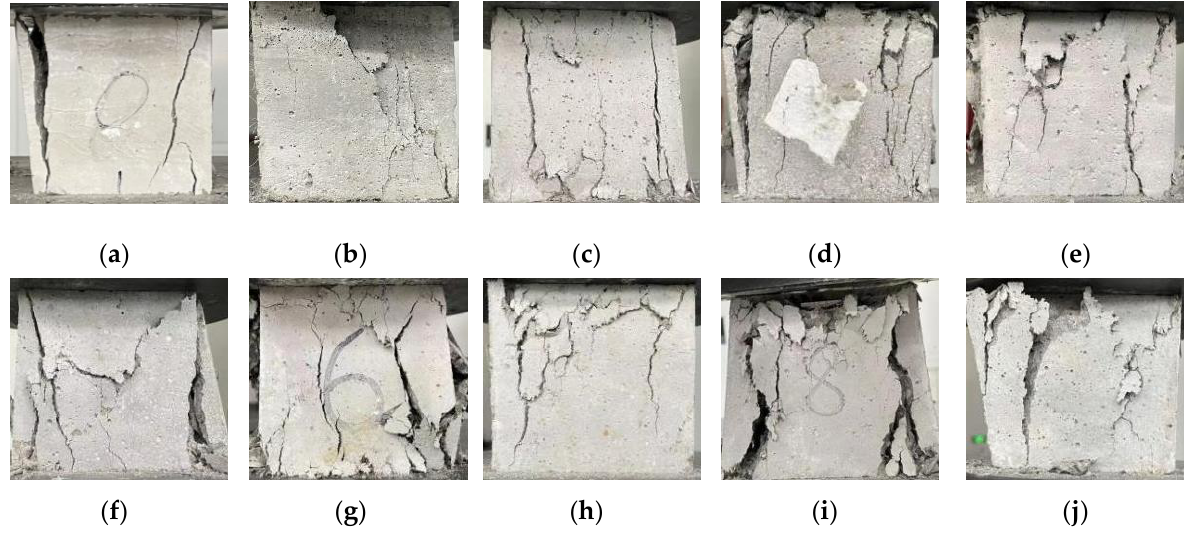
Figure 9. Failure pattern diagram. ( a ) OC-0, ( b ) HFRRC-1, ( c ) HFRRC-2, ( d ) HFRRC-3, ( e ) HFRRC-4, ( f ) HFRRC-5, ( g ) HFRRC-6, ( h ) HFRRC-7, ( i ) HFRRC-8, and ( j ) HFRRC-9. ( g ) HFRRC-6, ( h ) HFRRC-7, ( i ) HFRRC-8, and ( j )